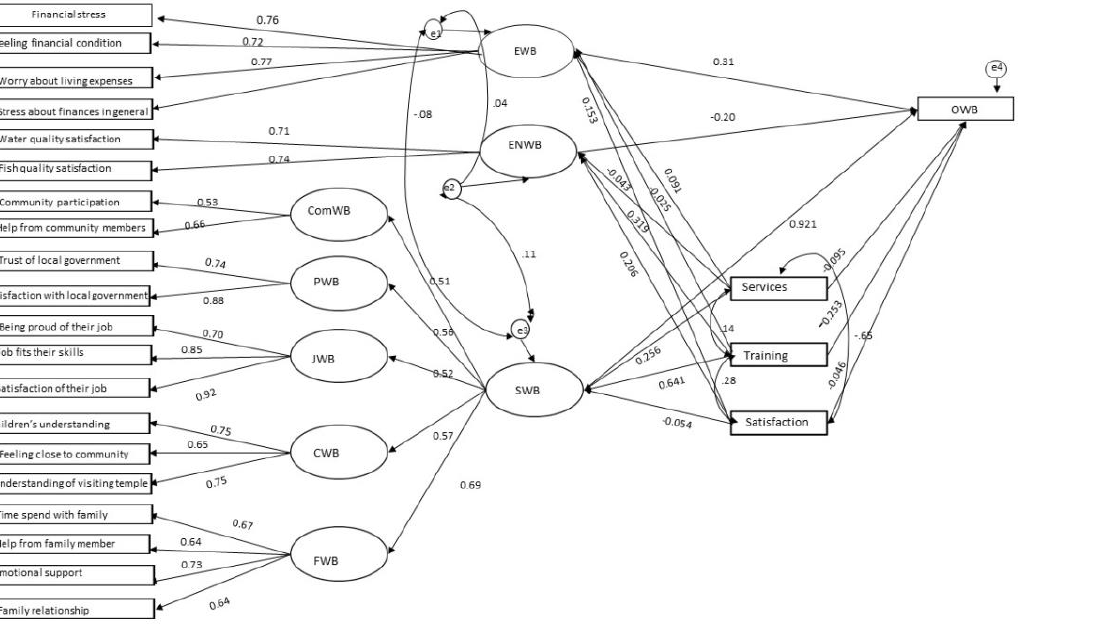
Figure 1: The full path diagram for the combination of the modified measurement model and the structural model; Source: Chaiyamart et al.,